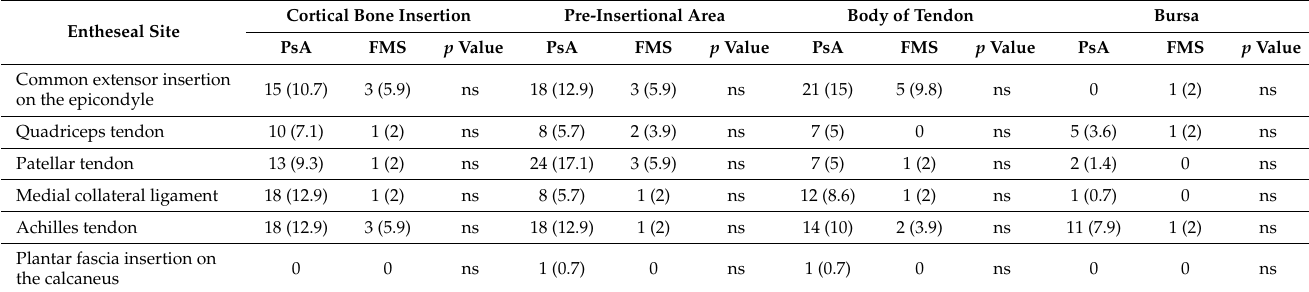
Table 4. Frequency of the presence of PD-US changes at the examined entheseal sites in patients with PsA ( n = 140) and those with FMS ( n = 51).